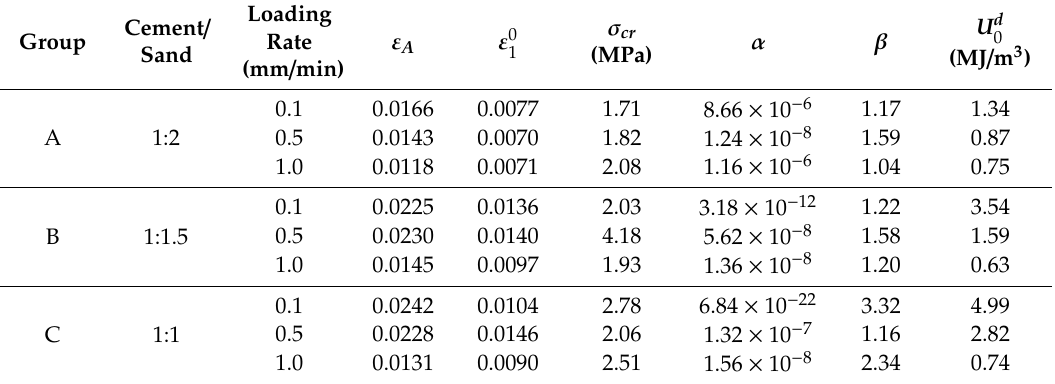
Table 5. Parameters of damage constitutive model of cement mortar specimens.